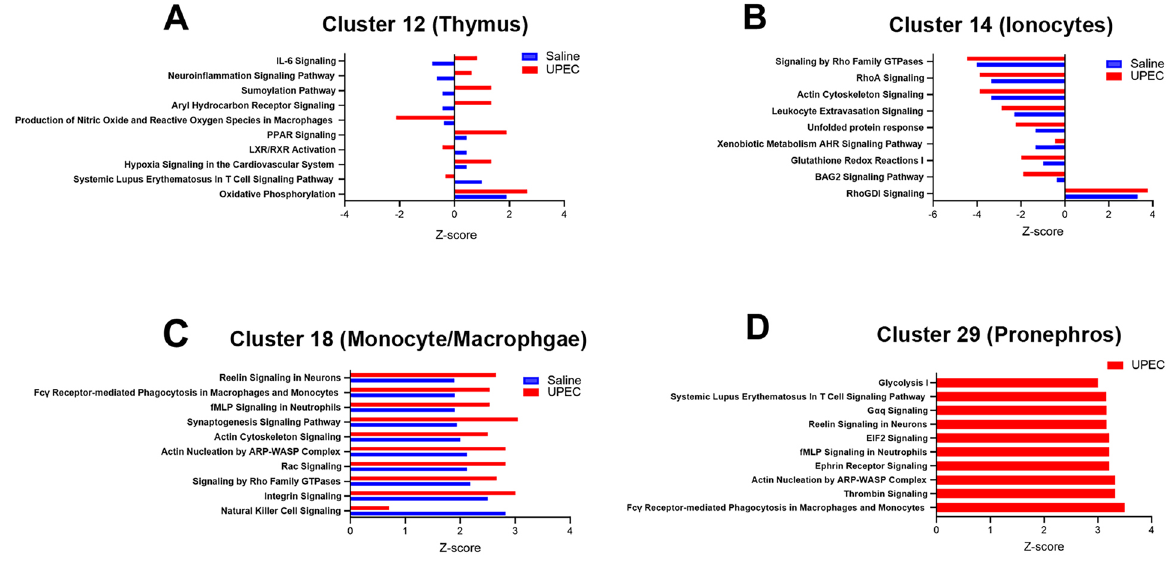
Figure 3 : Ingenuity canonical pathway (IPA) analysis of selected cell clusters . Data is presented for top 10 pathways which had –log P value >1.3 and z-score changes with treatment condition. For cluster 29 pathway list was generated from UPEC treatment alone. Positive z-scores indicate activation and negative z-scores indicate inhibition of the